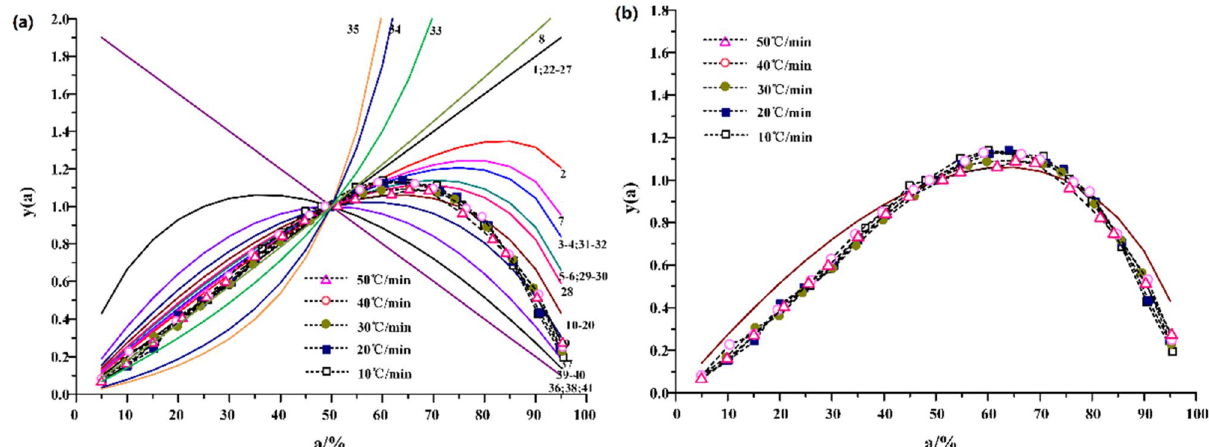
Figure 2. Standard and experimental curves of y(α)-α under N 2 .